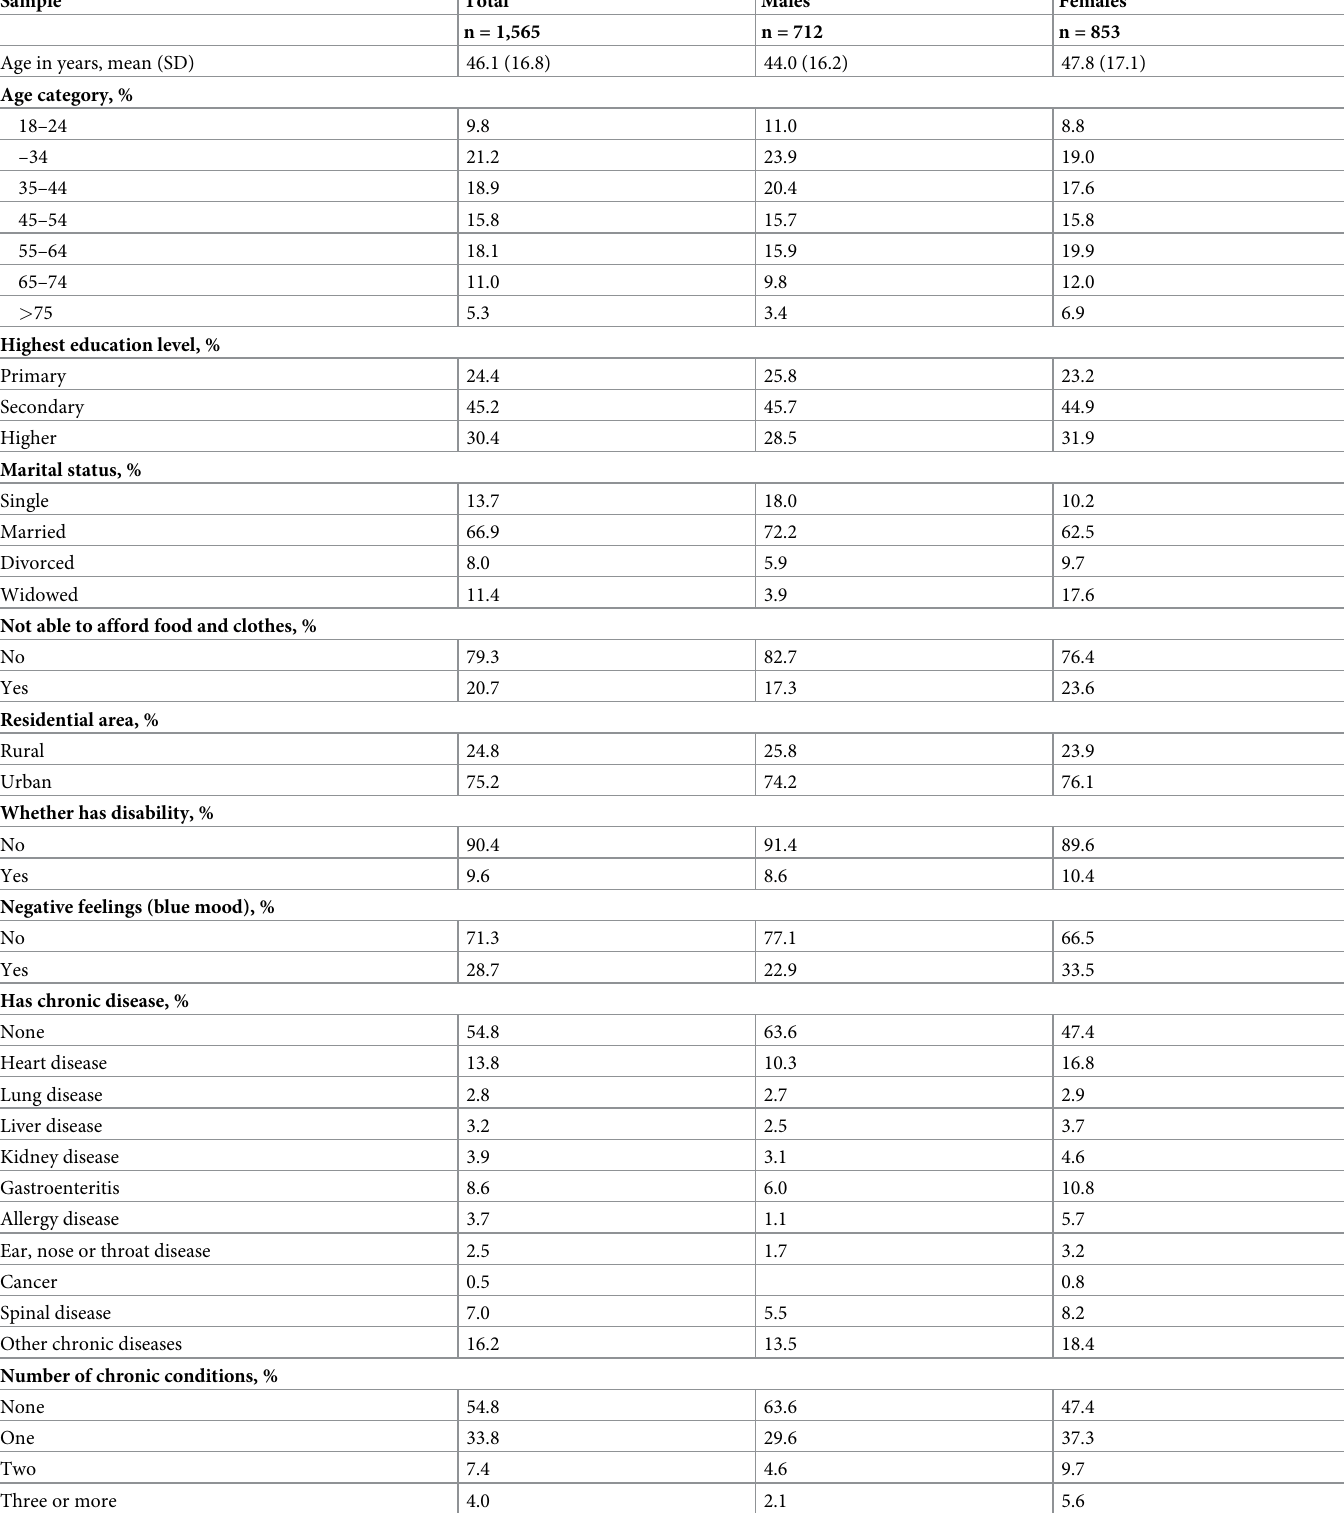
Table 1. Participants’